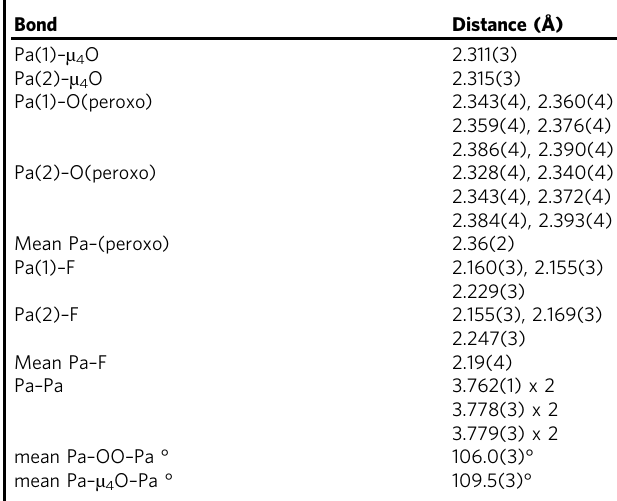
Table 1 Bond distances and angles for Rb 6 [Pa 4 O(O 2 ) 6 F 12 ]